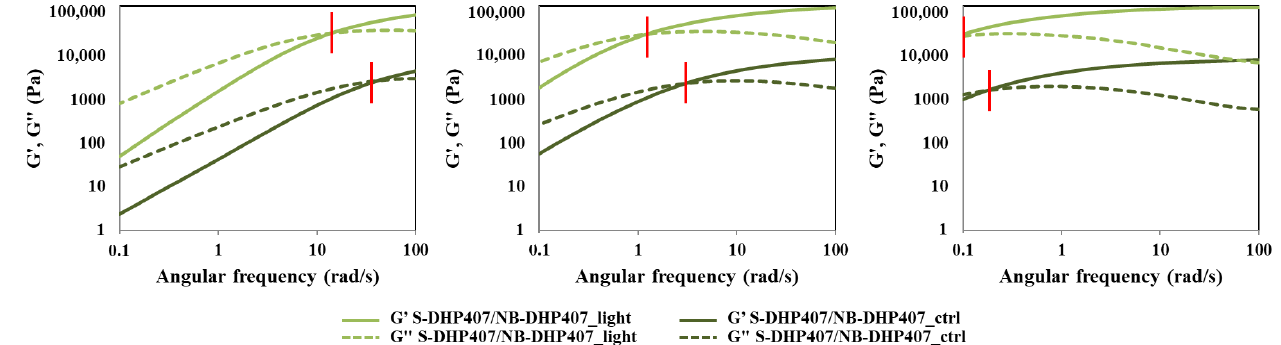
Figure 8. Frequency sweep tests conducted at 25 °C, 30 °C and 37 °C (from left to right) on S- DHP407/NB-DHP407 formulations before (dark green) and after (light green) exposure to green light (525 nm, 80,000 Lux for 10 min). Continuous and dashed lines represent the storage (G’) and loss (G”) moduli, respectively, while the red bars identify the G’/G” crossover frequency. For higher clarity, G’ and G” values of control samples were divided by a factor of 10.